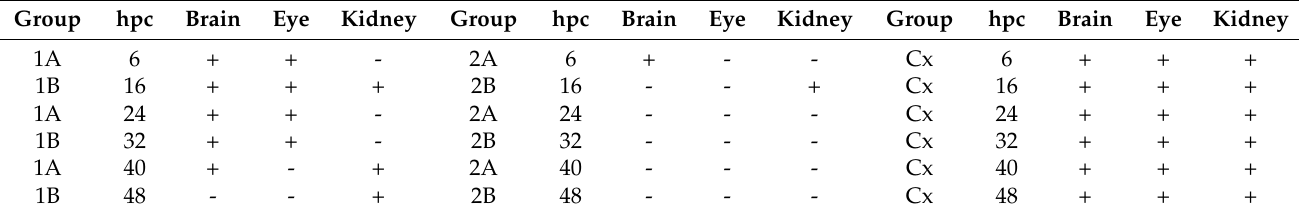
Table 2. The number, percentage survival and percentage mortality in Red hybrid tilapia after challenged with 1 × 10 6 CFU/mL live S. iniae by intraperitoneal injection. Table 3. Isolation of S. iniae from various organs of vaccinated fish (Groups 1A, 1B, 2A, 2B, and control Group Cx at different time intervals post-challenge.